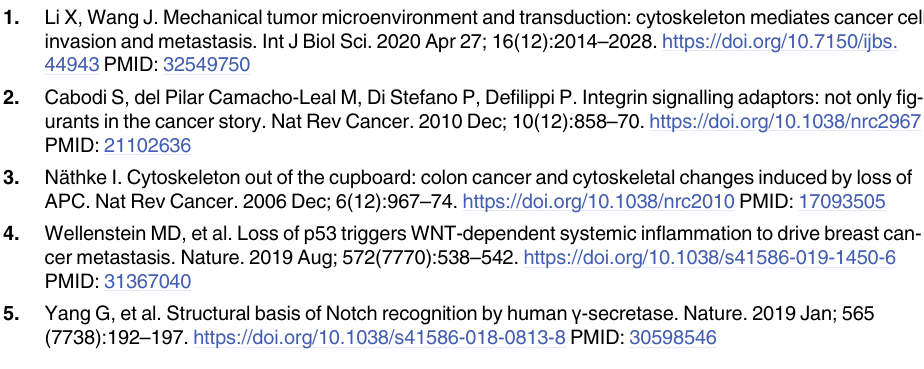
S1 Table. Characteristics of the patients with PCNSL enrolled in the study. (PDF) S2 Table. Information for the R version and attached packages used in the study. S3 Table. A list of the genes analyzed in the study. S4 Table. Multivariable risk factors from cox hazard model in tumor morphology and microenvironment of PCNSL. S5 Table. Summary of the gene signature candidates associated with cancer morphology and microenvironment and the differential expression with MTX resistance in